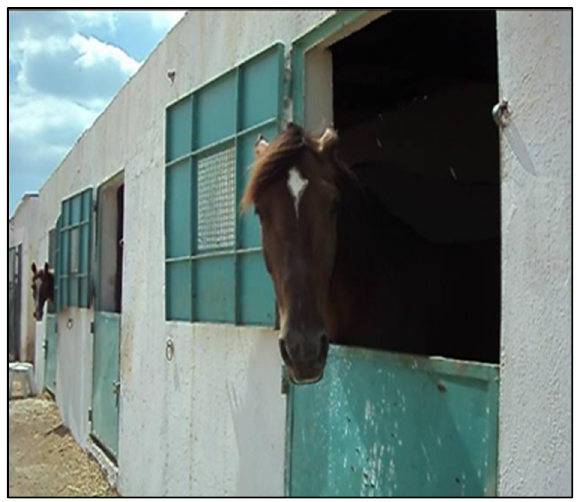
Table 2. Metrics of Transfer Learning for the Evaluation of Model Performance.